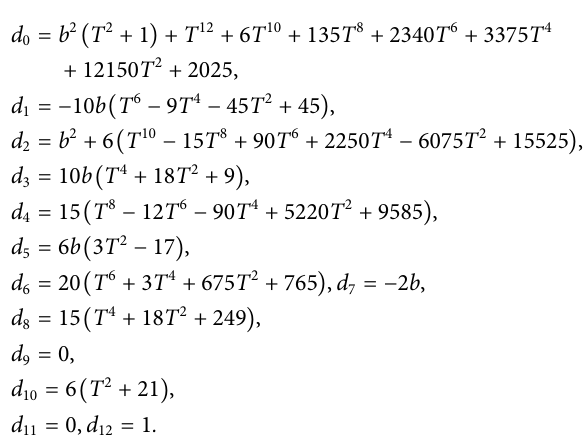
Frontiers in Physics |